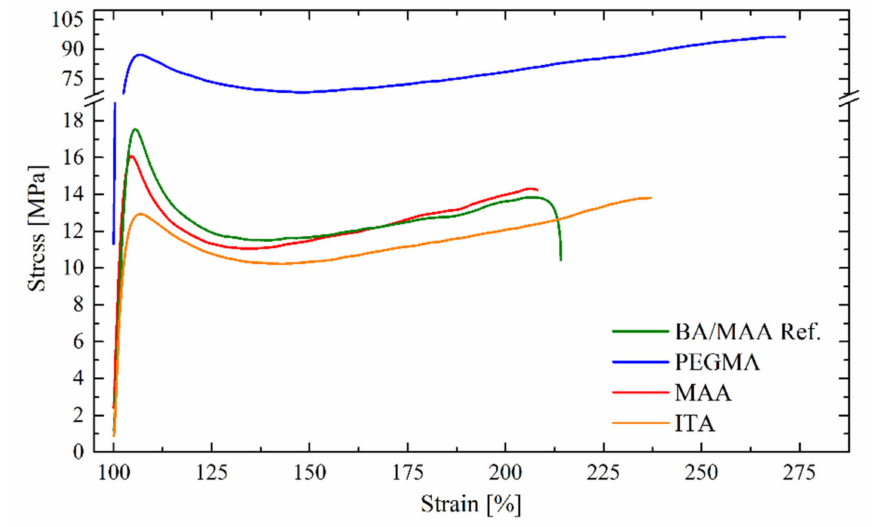
Figure 4. Stress–strain curves for the used films prepared with THPs annealed 24 h at 60 ◦ C.